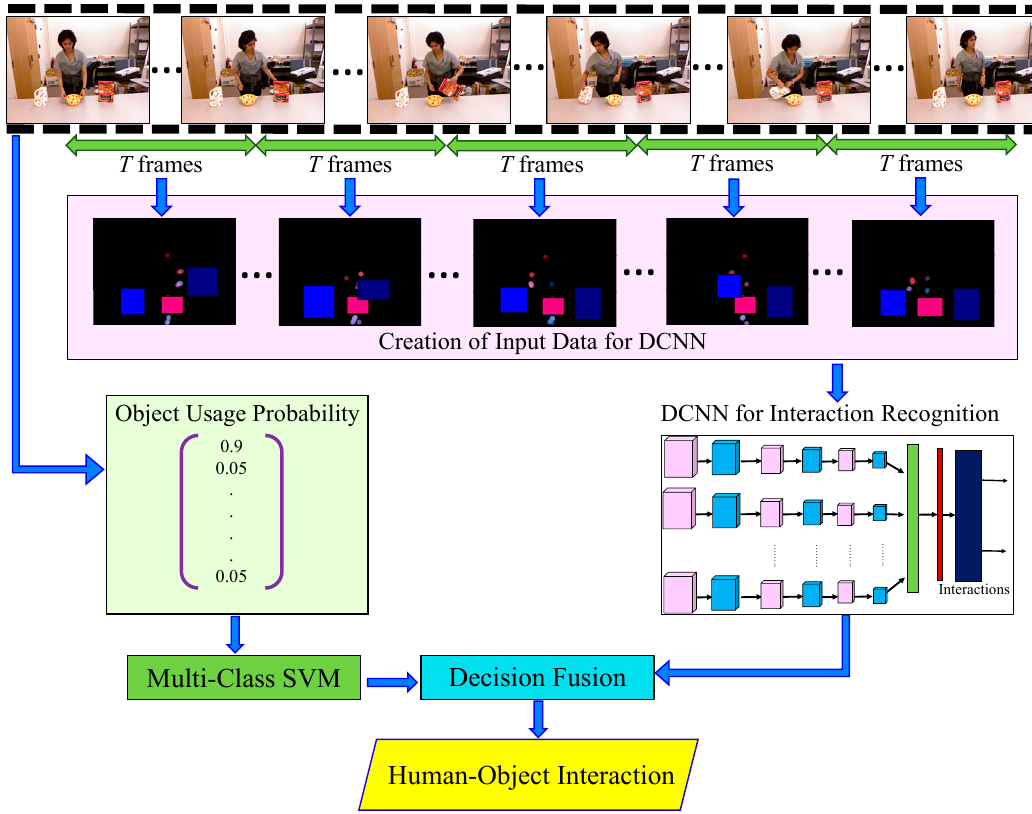
Figure 1. Architecture of a complex human–object interaction recognition system. DCNN: deep convolutional neural network; SVM: support vector machine.